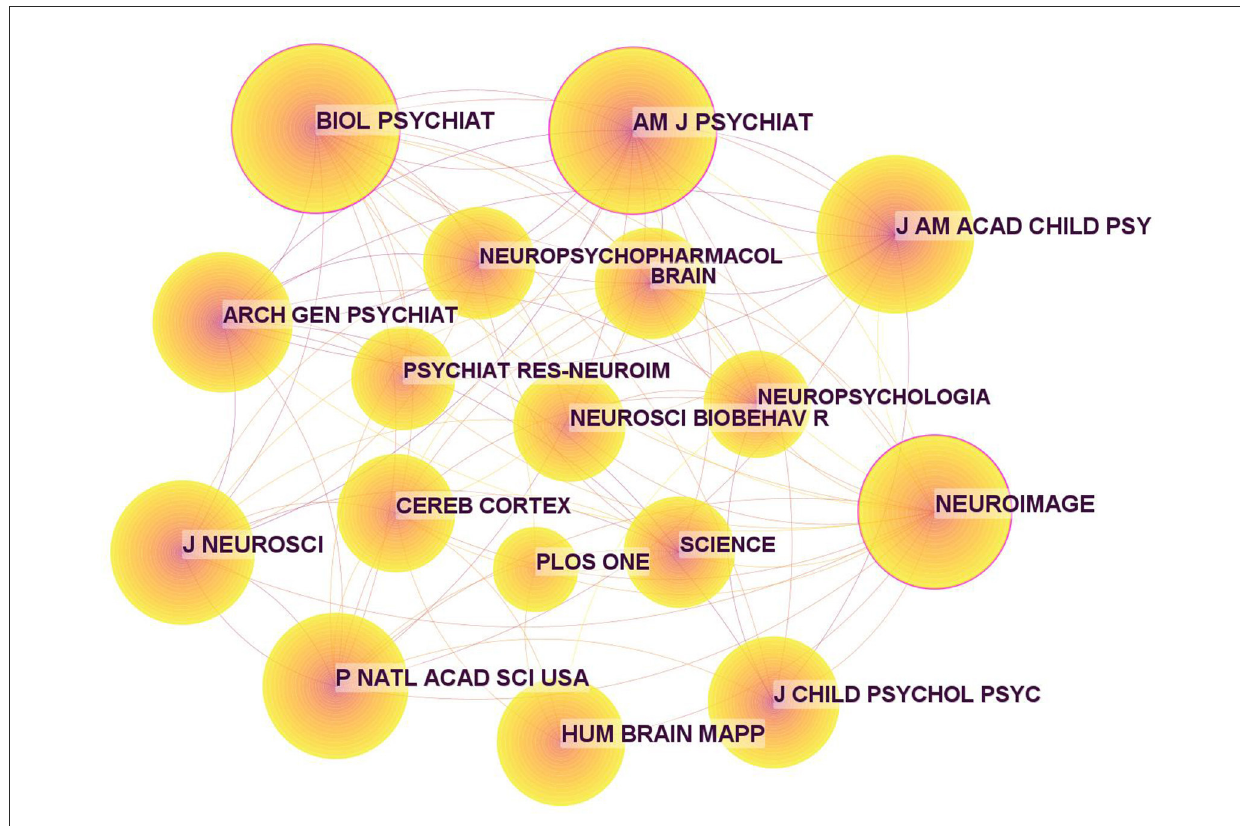
FIGURE7 Map of cited journals for ADHD neuroimaging from 1992 to 2022.